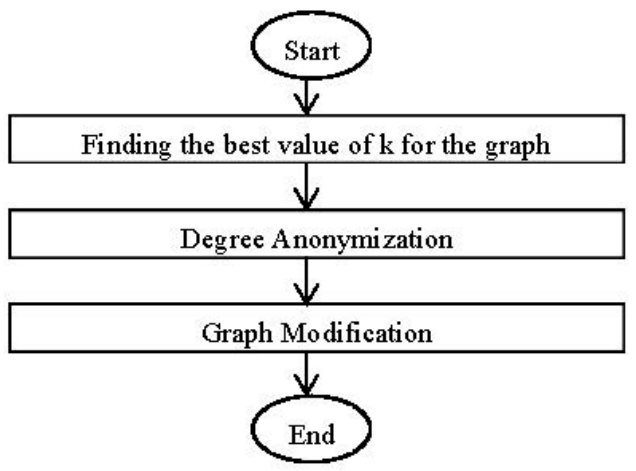
Figure 2. Flowchart of the proposed algorithm .